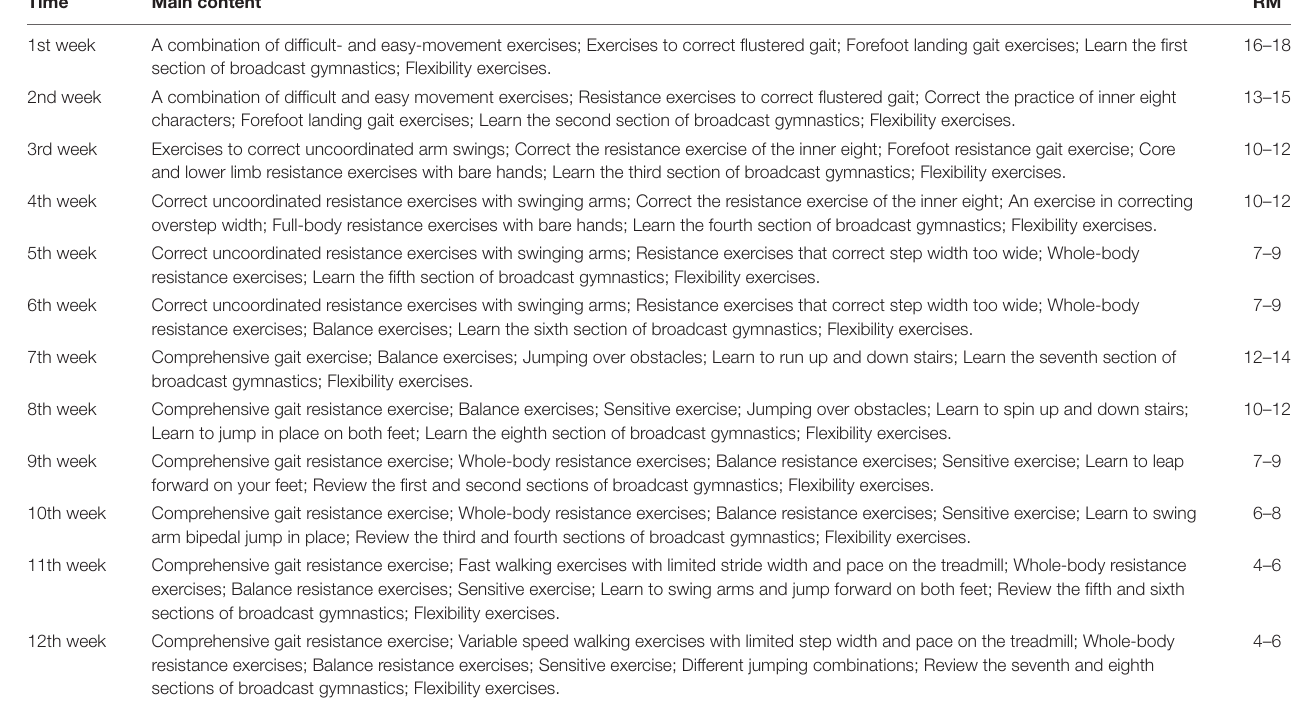
TABLE 1 | The main content of exercise